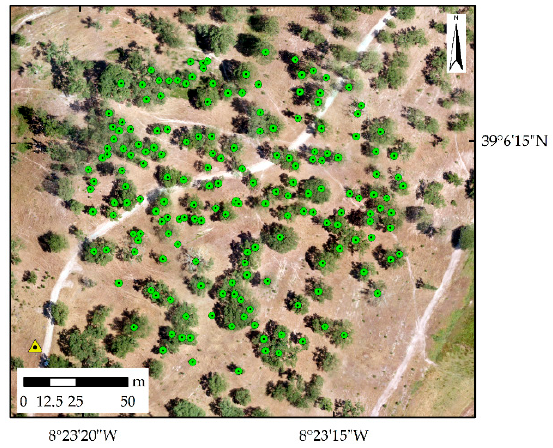
Table 1. Image’s acquisition dates (Sentinel-2 Level-2A images and UAV images).